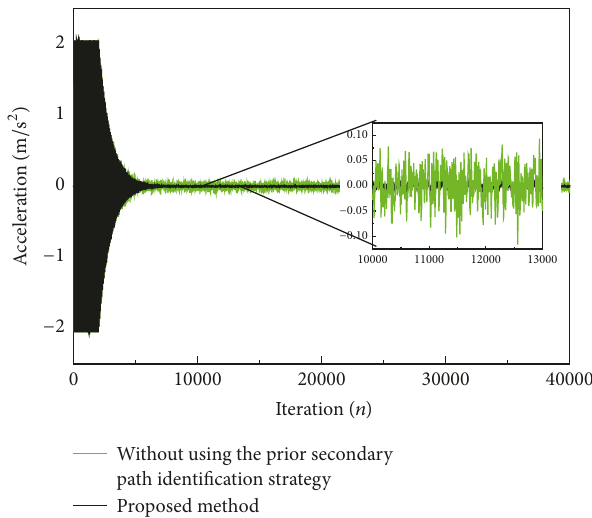
Figure 7: Acceleration of the controlled point of the proposed method.